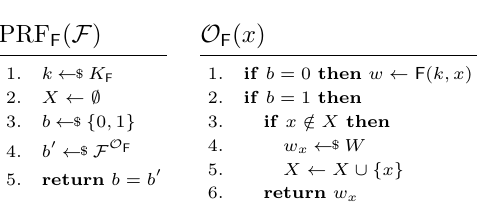
Figure 1: The PRF security